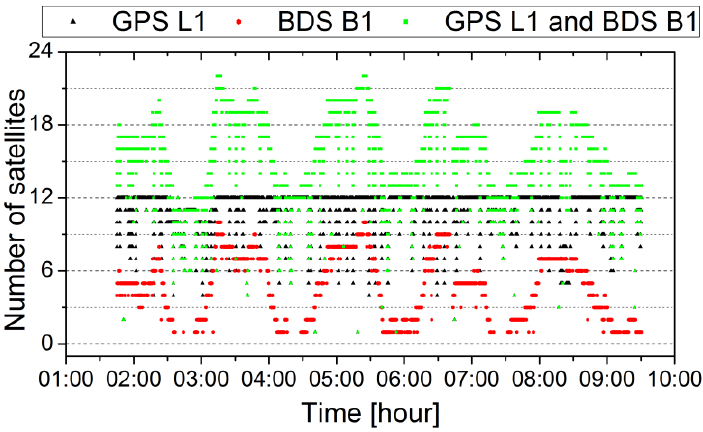
Figure 6. Number of visible GPS and BDS satellites.